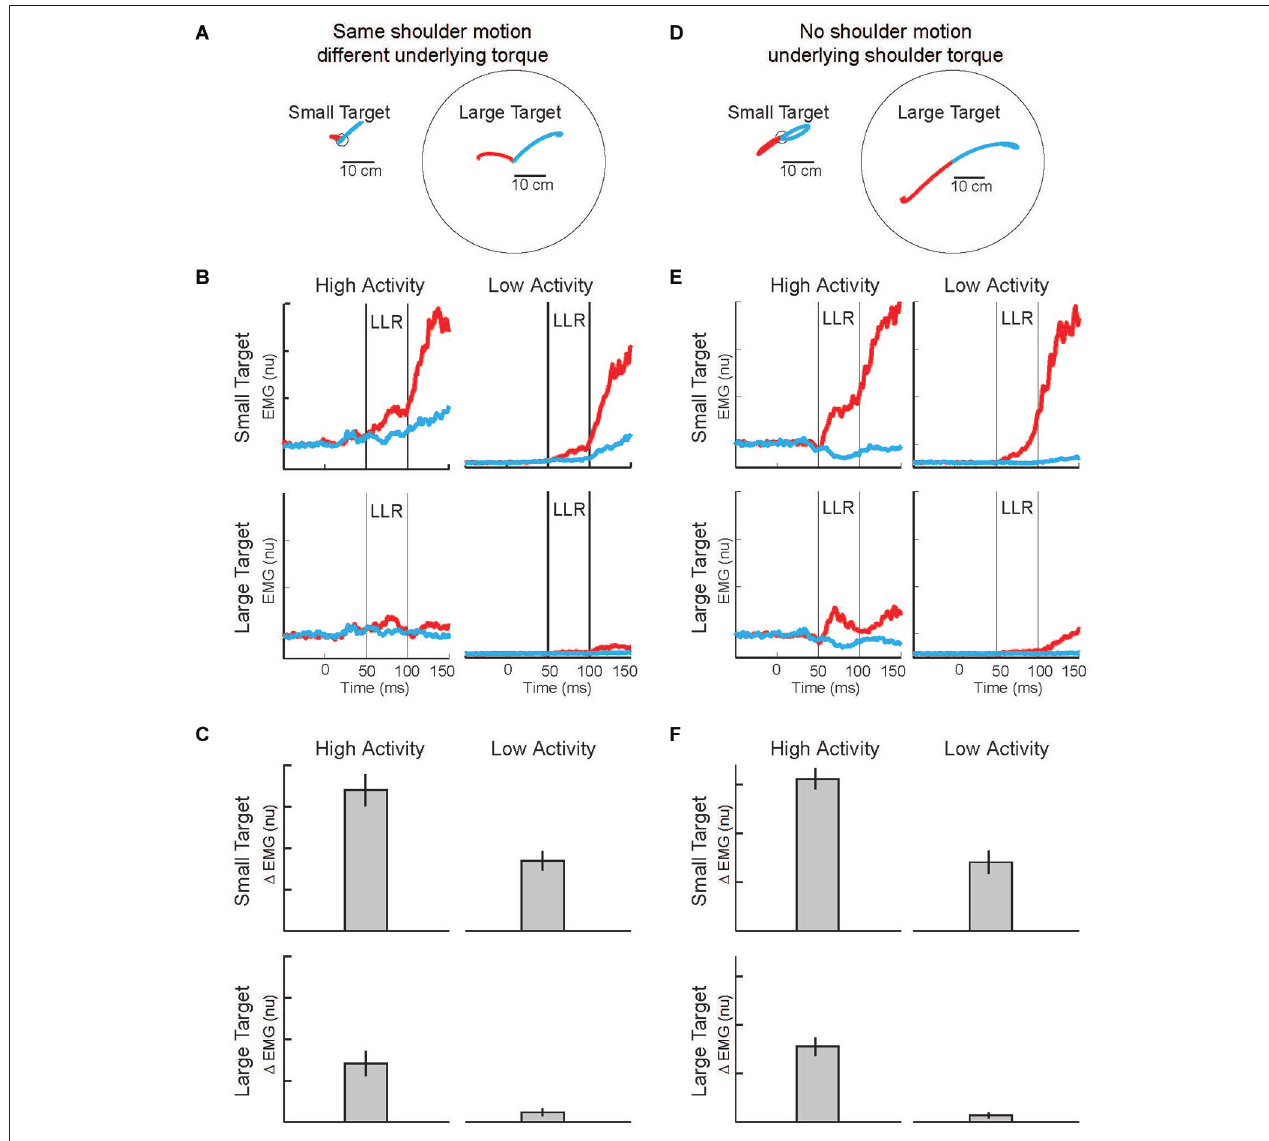
muscle activity (compare to predictions in Figure 7 ). (D) Torque perturbations applied to the arm, a shoulder + elbow flexor torque (red arm) and a shoulder + elbow extensor torque (blue arm). Red and blue traces show hand paths resulting from the perturbations, same format as above. (E) Group average muscle activity evoked by the shoulder + elbow flexor torque (red) and shoulder + elbow extensor torque (bue). (F) Differential activity of the LLR to the pair of perturbations (shoulder flexor+elbow flexor torque and shoulder extensor+elbow extensor torque) given the four combinations of target size+background muscle activity (compare to predictions in Figure 7 ). Figure modified with permission from Kurtzer et al.